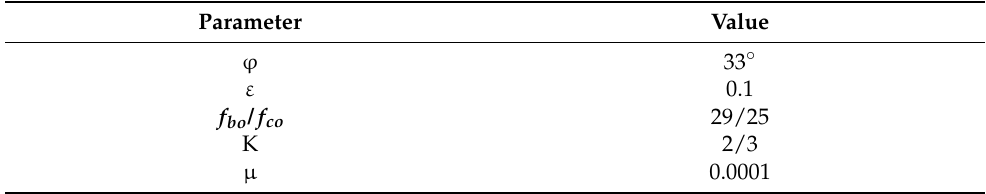
Table 5. Parameters of the CDP model used in